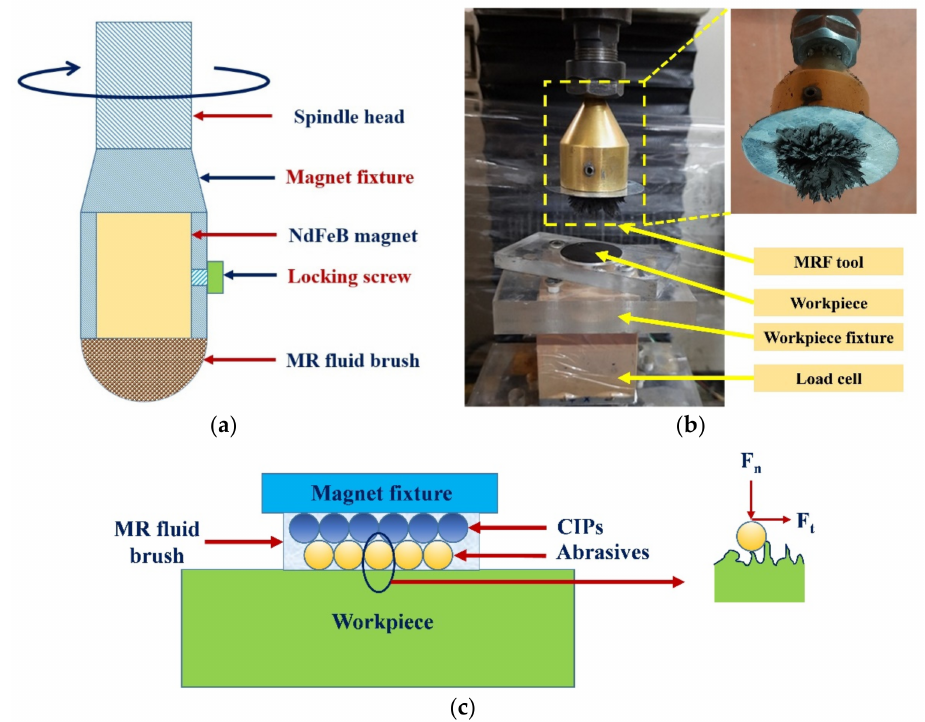
Figure 2. ( a ) Schematic of MRF tool, ( b ) experimental setup, and ( c ) schematic of MRF processing mechanism.